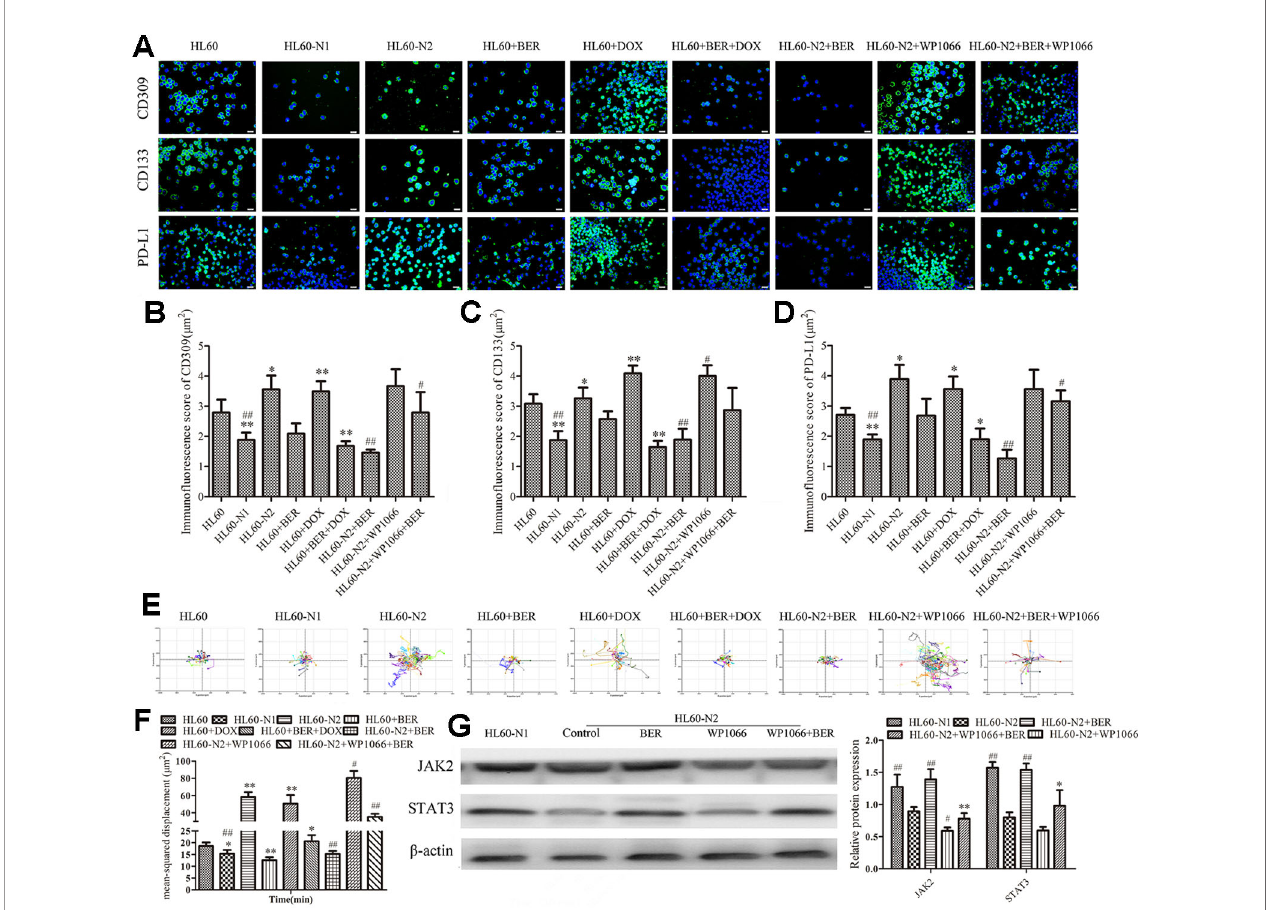
FIGURE 3 | N1-like and N2-like neutrophils showed different phenotypic characteristics in stemness, mobility and jak2/stat3 signaling. (A) Cell protein expression of CD309, CD133, and PD-L1 indicated by immuno fl uorescence (n = 5, 40×). (B – D) Immuno fl uorescence score of (A) (n = 5). (E) Cell mobility observed by a laser holographic cell imaging and analysis system (n = 5, 20×). (F) The quantitative value of (E) (n = 5). (G) Protein expression levels of jak2/stat3 examined by Western blotting (n = 5). The data present mean ± SD, the experiments were repeated three times, and statistical signi fi cance was determined by a t-test. (B – D , F) *P < 0.05, **P < 0.01 vs . HL60; # P < 0.05, ## P < 0.01 vs . HL60-N2. (G) *P < 0.05, **P < 0.01 vs . HL60-N2+BER; # P < 0.05, ## P < 0.01 vs . HL60-N2. DOX, doxorubicin; BER,